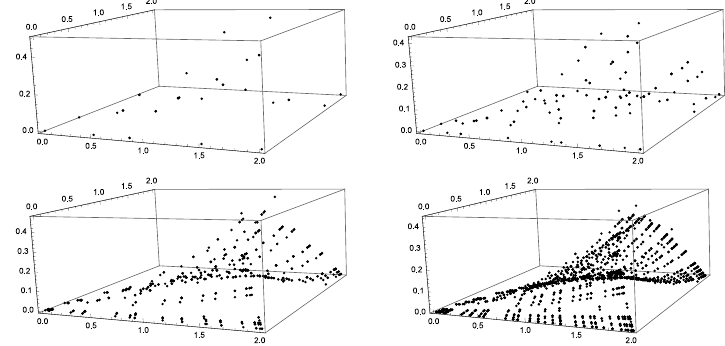
Figure 2: The control points from the first four iterations of subdivision.